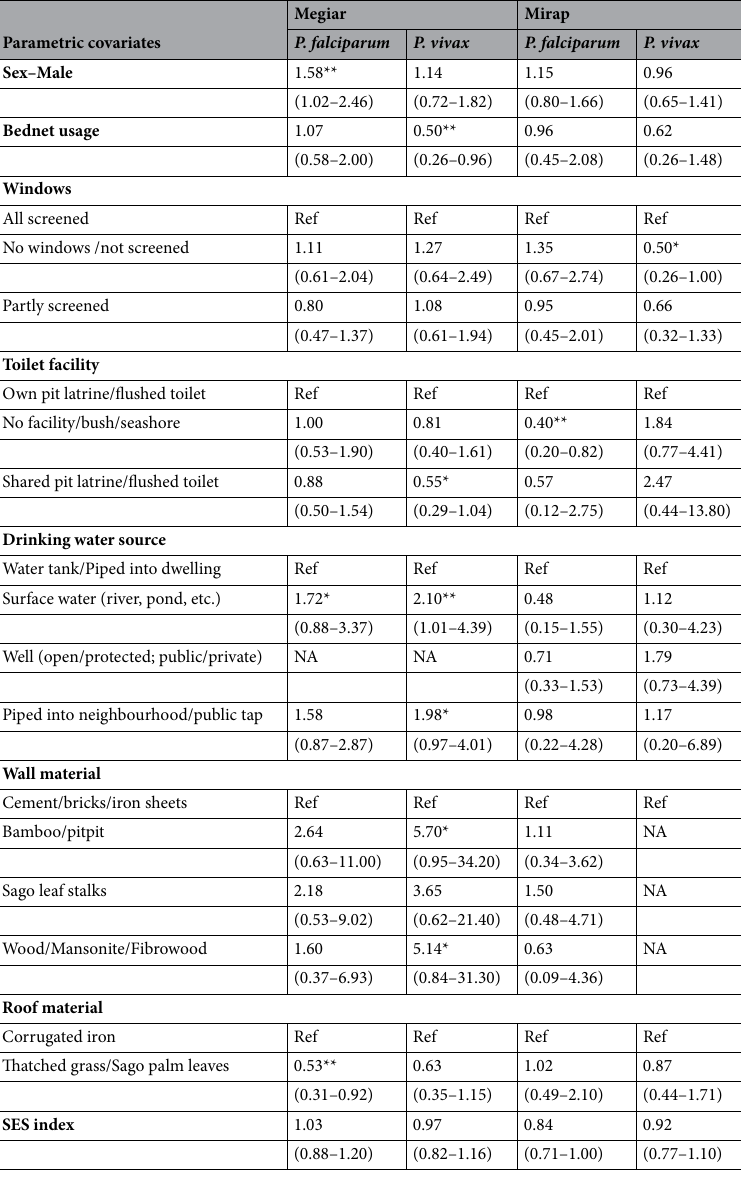
Table 2. Individual and household risk factors for individual Plasmodium spp. infection by village in 2016. Adjusted odds ratios from GAM. Data in parenthesis denote 95% confidence interval. Symbols